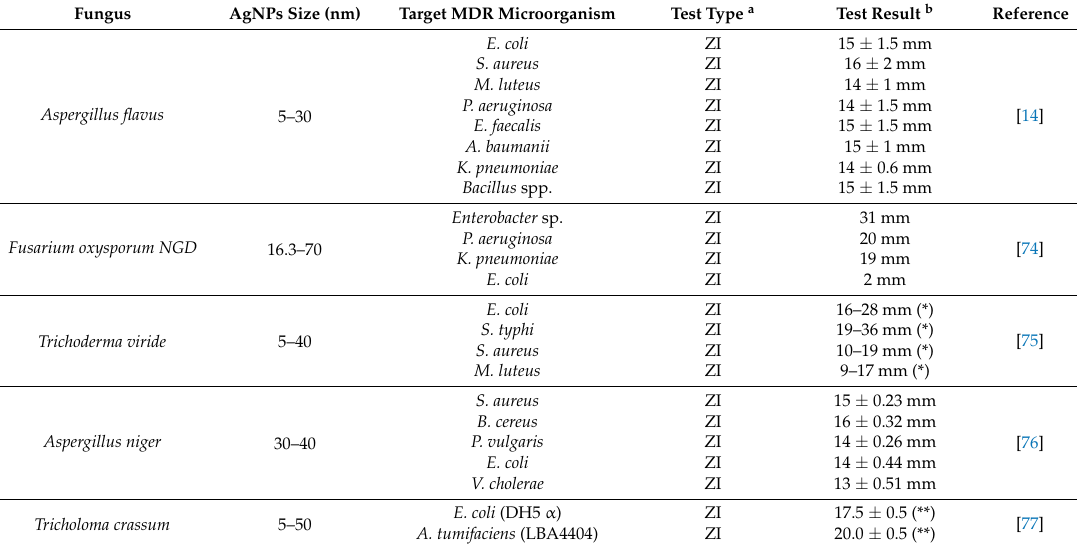
Table 1. Fungi-mediated AgNPs biosynthesis and their activity against